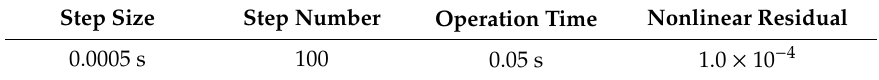
Table 2. The solver parameters.